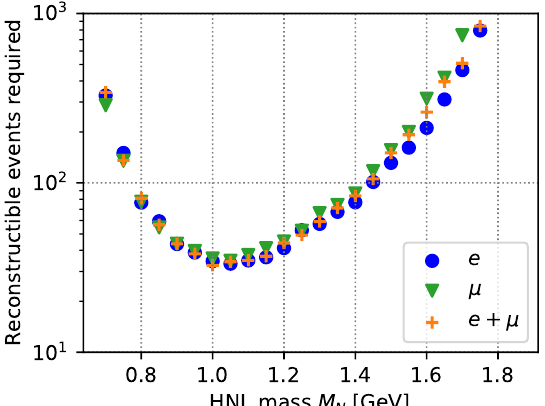
Figure 9. Number of fully reconstructible events required to detect LNV at 90% CL, for an HNL coupling to e , (cid:22) , or equally to